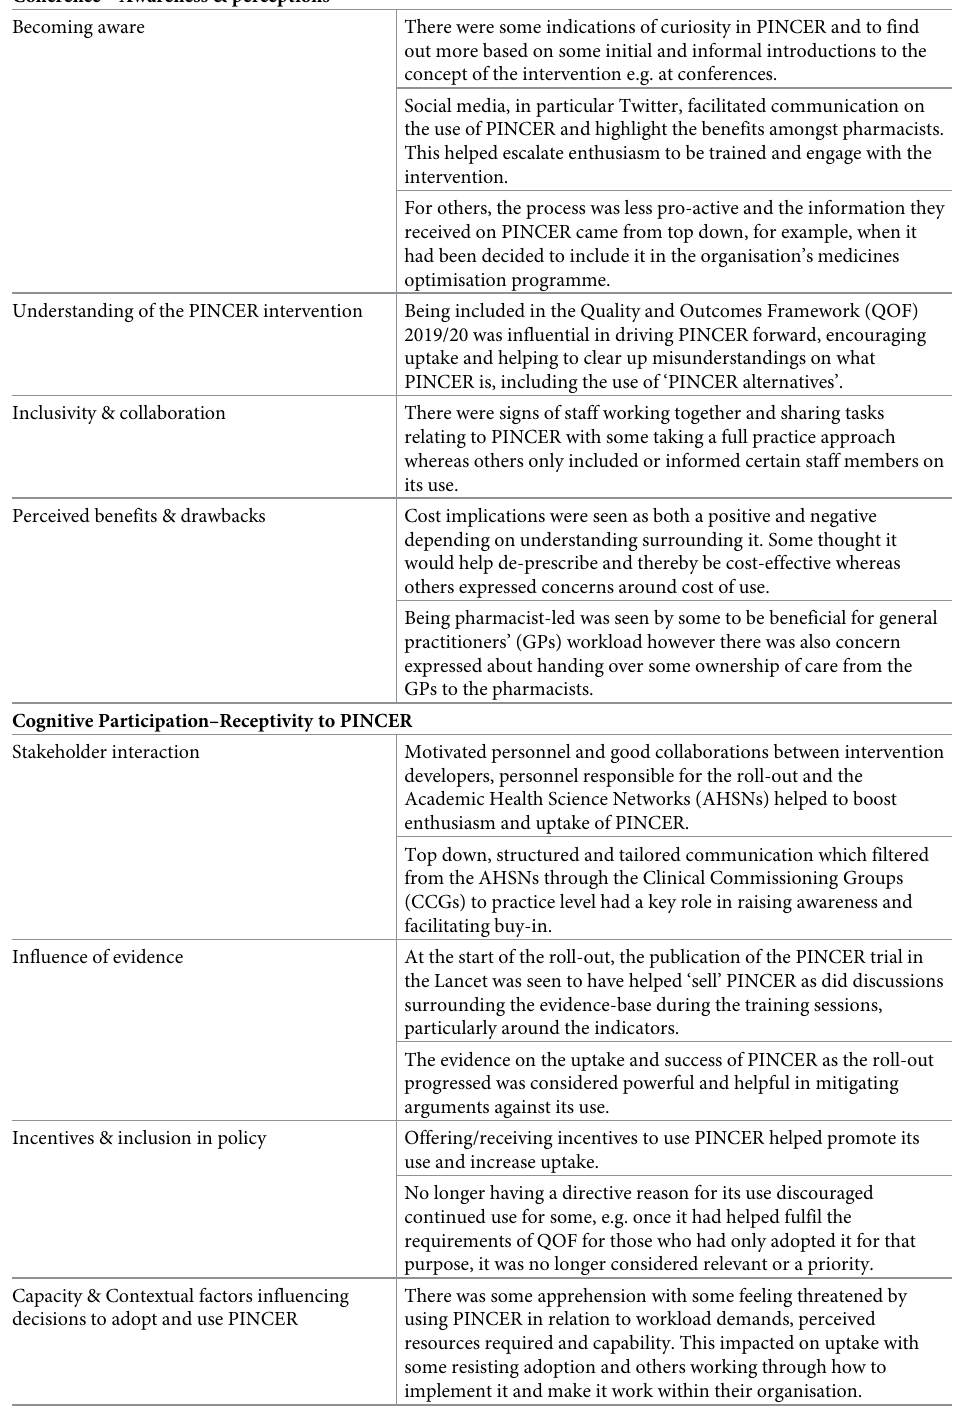
Table 5. Alignment of themes with the Normalisation Process Theory